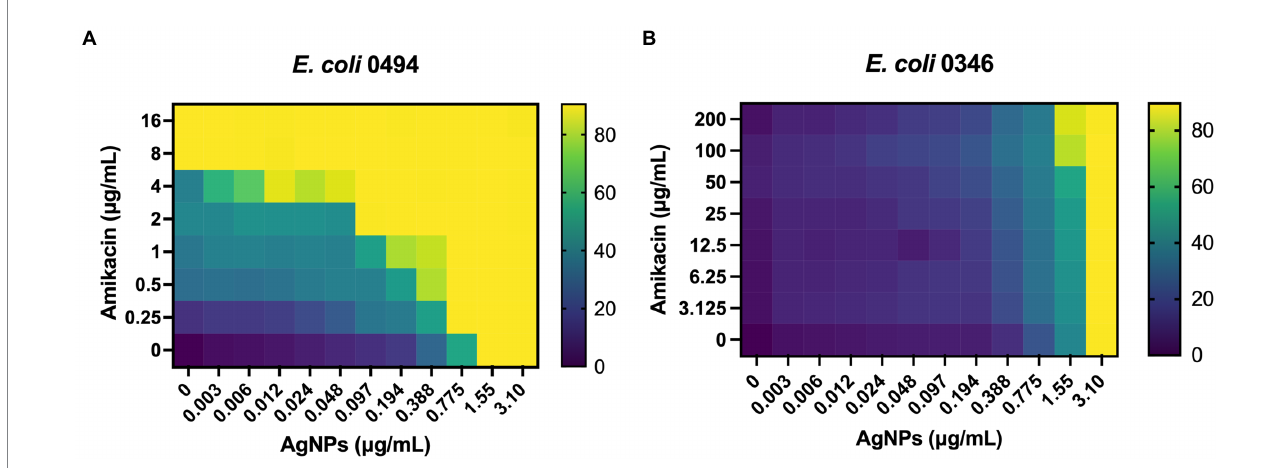
FIGURE 9 Checkerboard analysis of AgNP and amikacin combination against MDR E. coli . A dose–response combination of AgNPs with amikacin was tested against (A) E. coli 0494, amikacin-sensitive strain and (B) E. coli 0346, amikacin-resistant strain. The checkerboard represents an average of three independent experiments. The FICI for the amikacin-sensitive strain indicates a partial synergy. See Methods 2.3 for details. FICI = FIC AgNP + FIC Amikacin ; FIC AgNP = MIC AgNP combination/MIC AgNP alone; FIC Amikacin = MIC Amikacin combination/MIC Amikacin alone. Σ FICI = (0.755/1.55) + (0.25/8.0) =